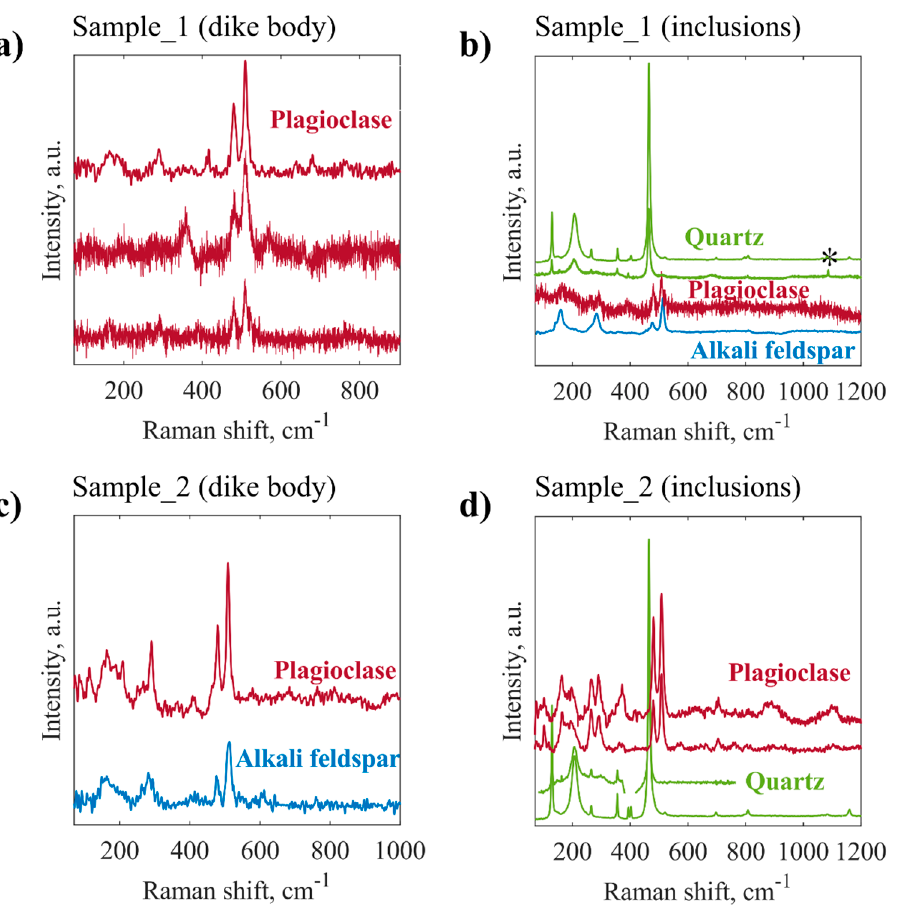
Figure 2. The selected Raman spectra obtained from different points on the surfaces of the studied rock samples, Sample_1 ( a —dike body, b —inclusions) and Sample_2 ( c —dike body, d —inclusions). Asterisk in panel ( b ) corresponds to the calcite principal Raman shift of 1086 cm − 1